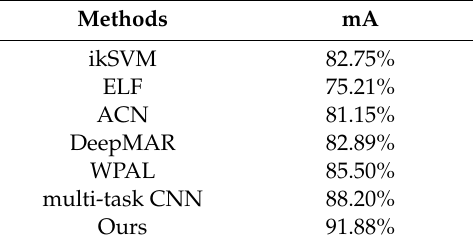
Table 3. Comparison results using di ff erent methods on the PETA